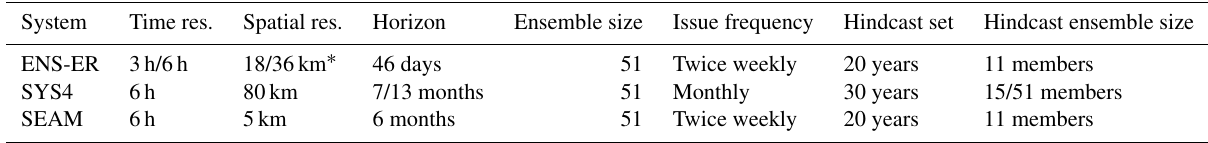
Table 1. Technical details of the forecast and the hindcast used in this paper. System Time res. Spatial res. Horizon Ensemble size Issue frequency Hindcast set Hindcast ensemble size ENS-ER 3h/6h 18/36km ∗ 46 days 51 Twice weekly 20 years 11 members SYS4 6h 80km 7/13 months 51 Monthly 30 years 15/51 members SEAM 6h 5km 6 months 51 Twice weekly 20 years 11